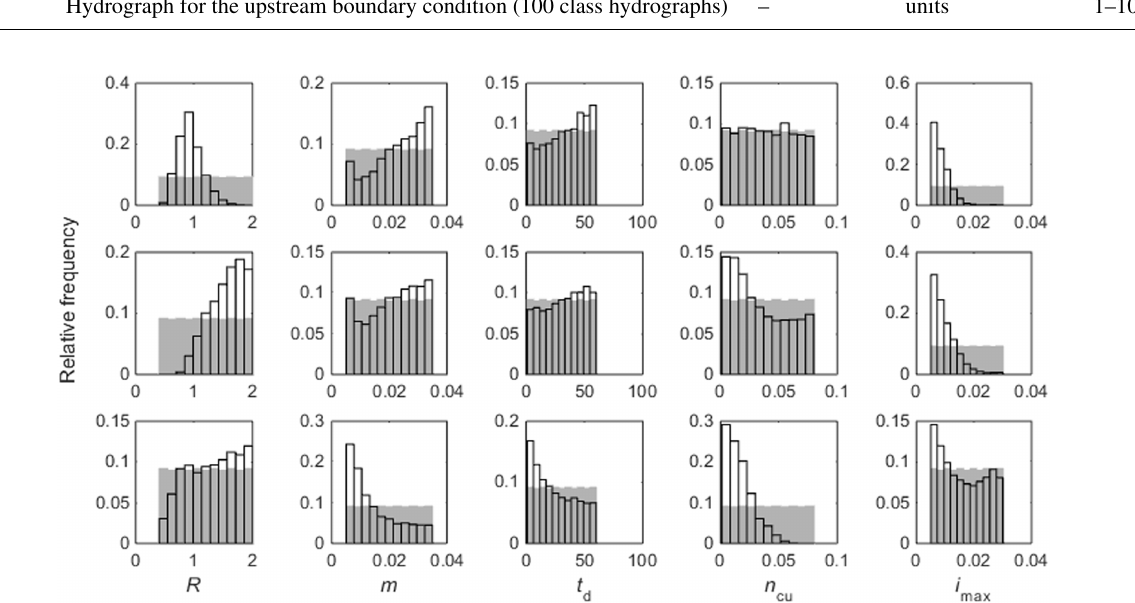
Figure 7. Prior (grey) and posterior (black outlined) relative frequency distribution for the most sensitive rainfall–runoff parameters: rainfall multiplier ( R ), rate of depletion ( m ), time factor ( t d ), the main channel roughness coefficient ( n cu ) and the maximum soil infiltration rate ( imax ) for the Chiquito, Guacerique, and Grande catchments (first, second, and third rows